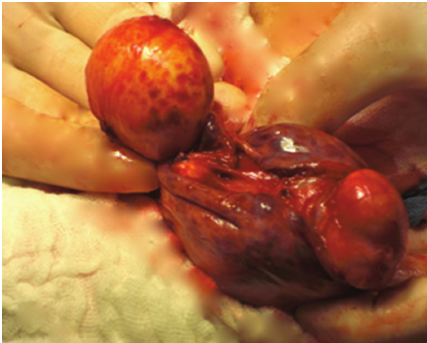
Figure 3: the right-sided dermoid cyst was entirely removed, allowing the preservation of the residual ovary.